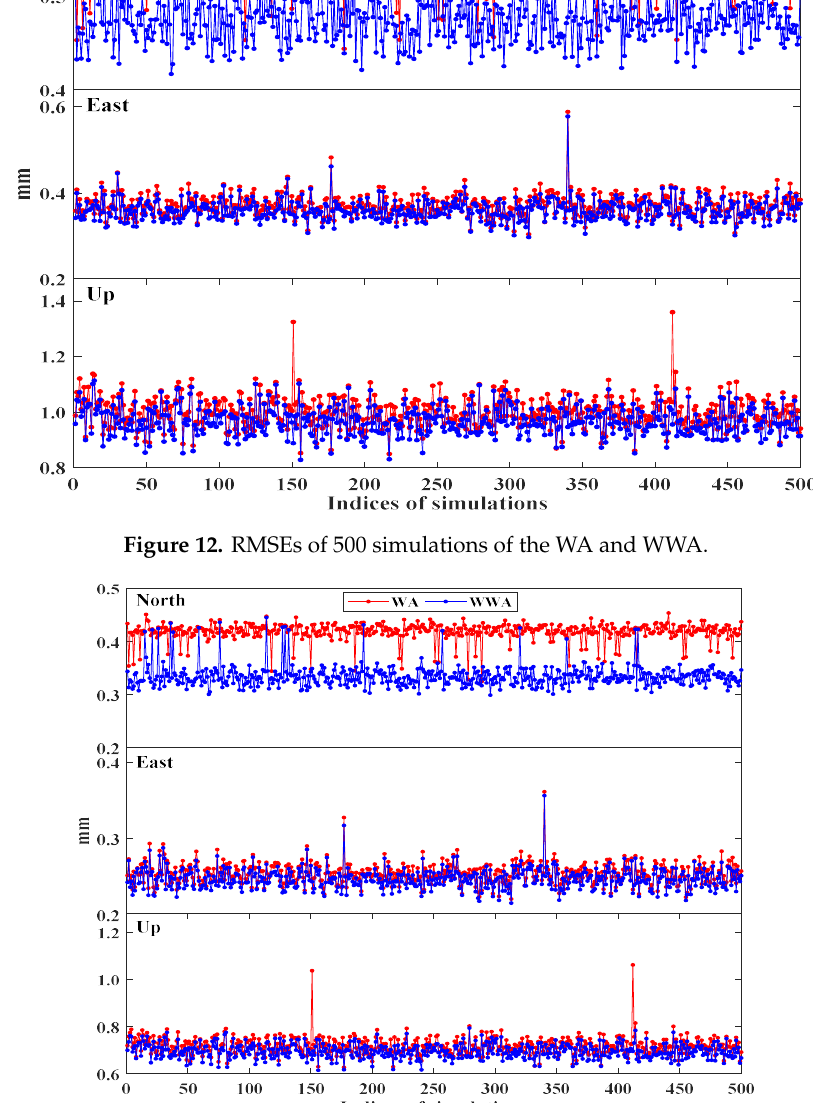
Figure 13. MAEs of 500 simulations of the WA and WWA.